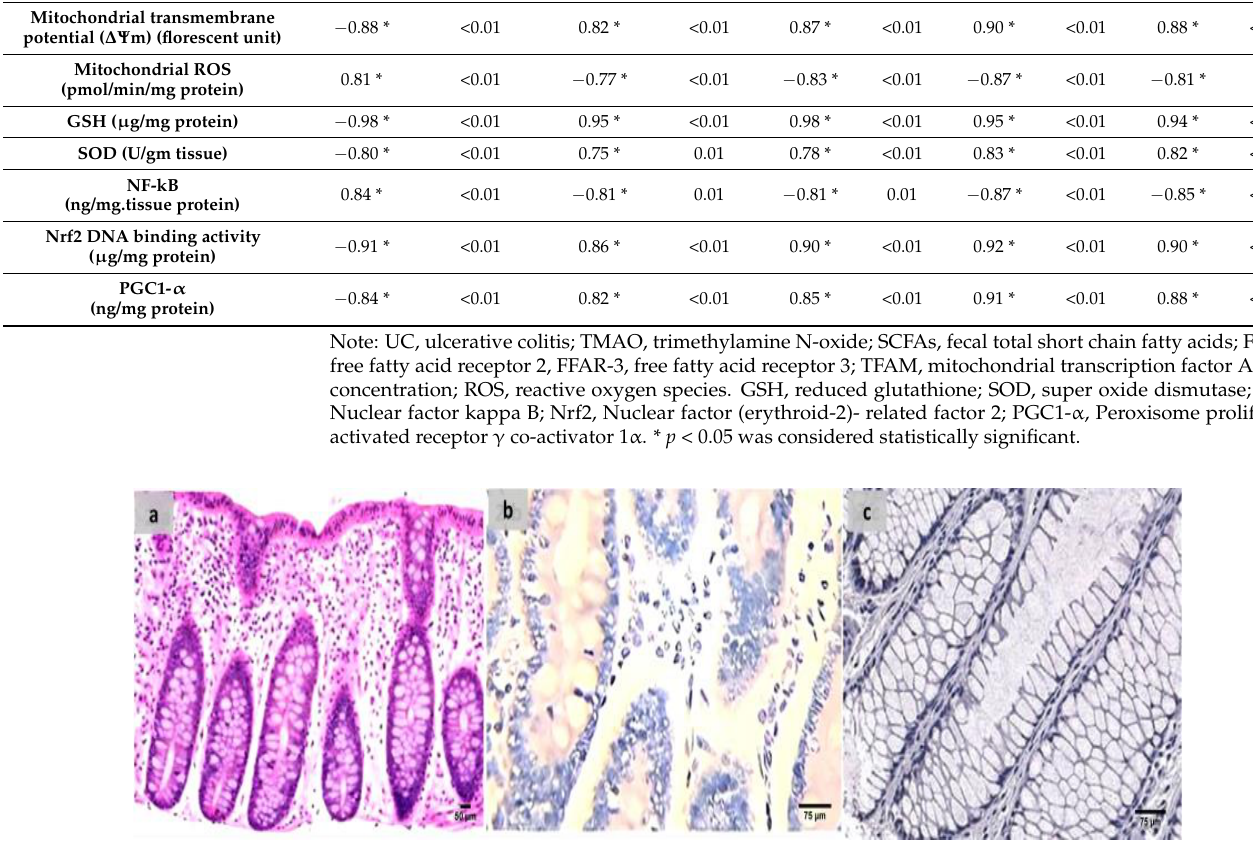
Figure 2. ( a ) Normal control colon specimen (H&E x100), ( b ) normal colon stained by calprotectin showed negative expression (x200), ( c ): normal colon stained by S100A12 showed negative expres- sion (x200).